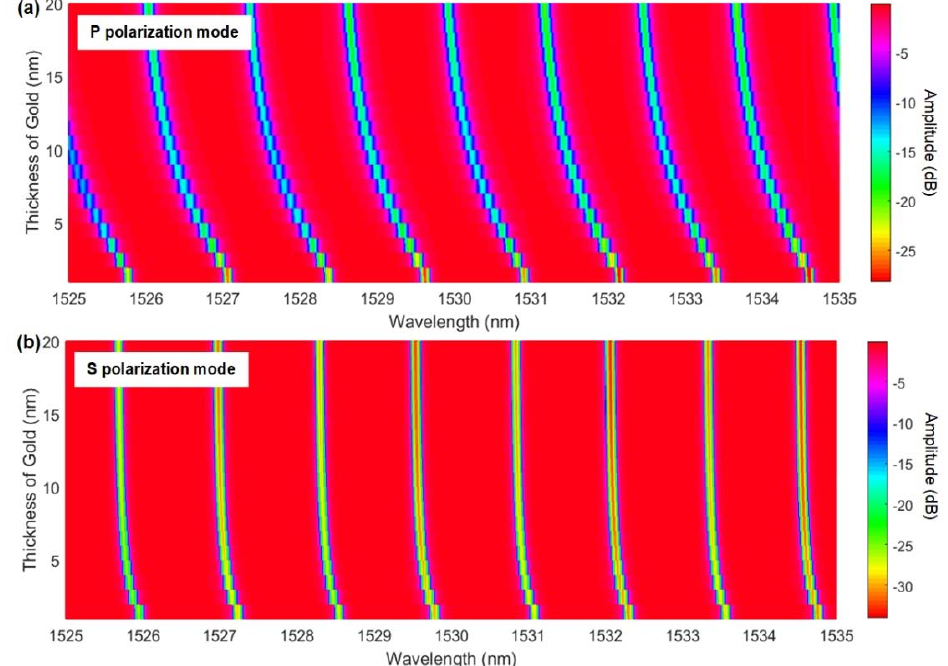
Figure 7. Simulation of the evolution of ( a ) P-polarized and ( b ) S-polarized resonances as a function of gold thickness, using the bulk permittivity of gold at these wavelengths.